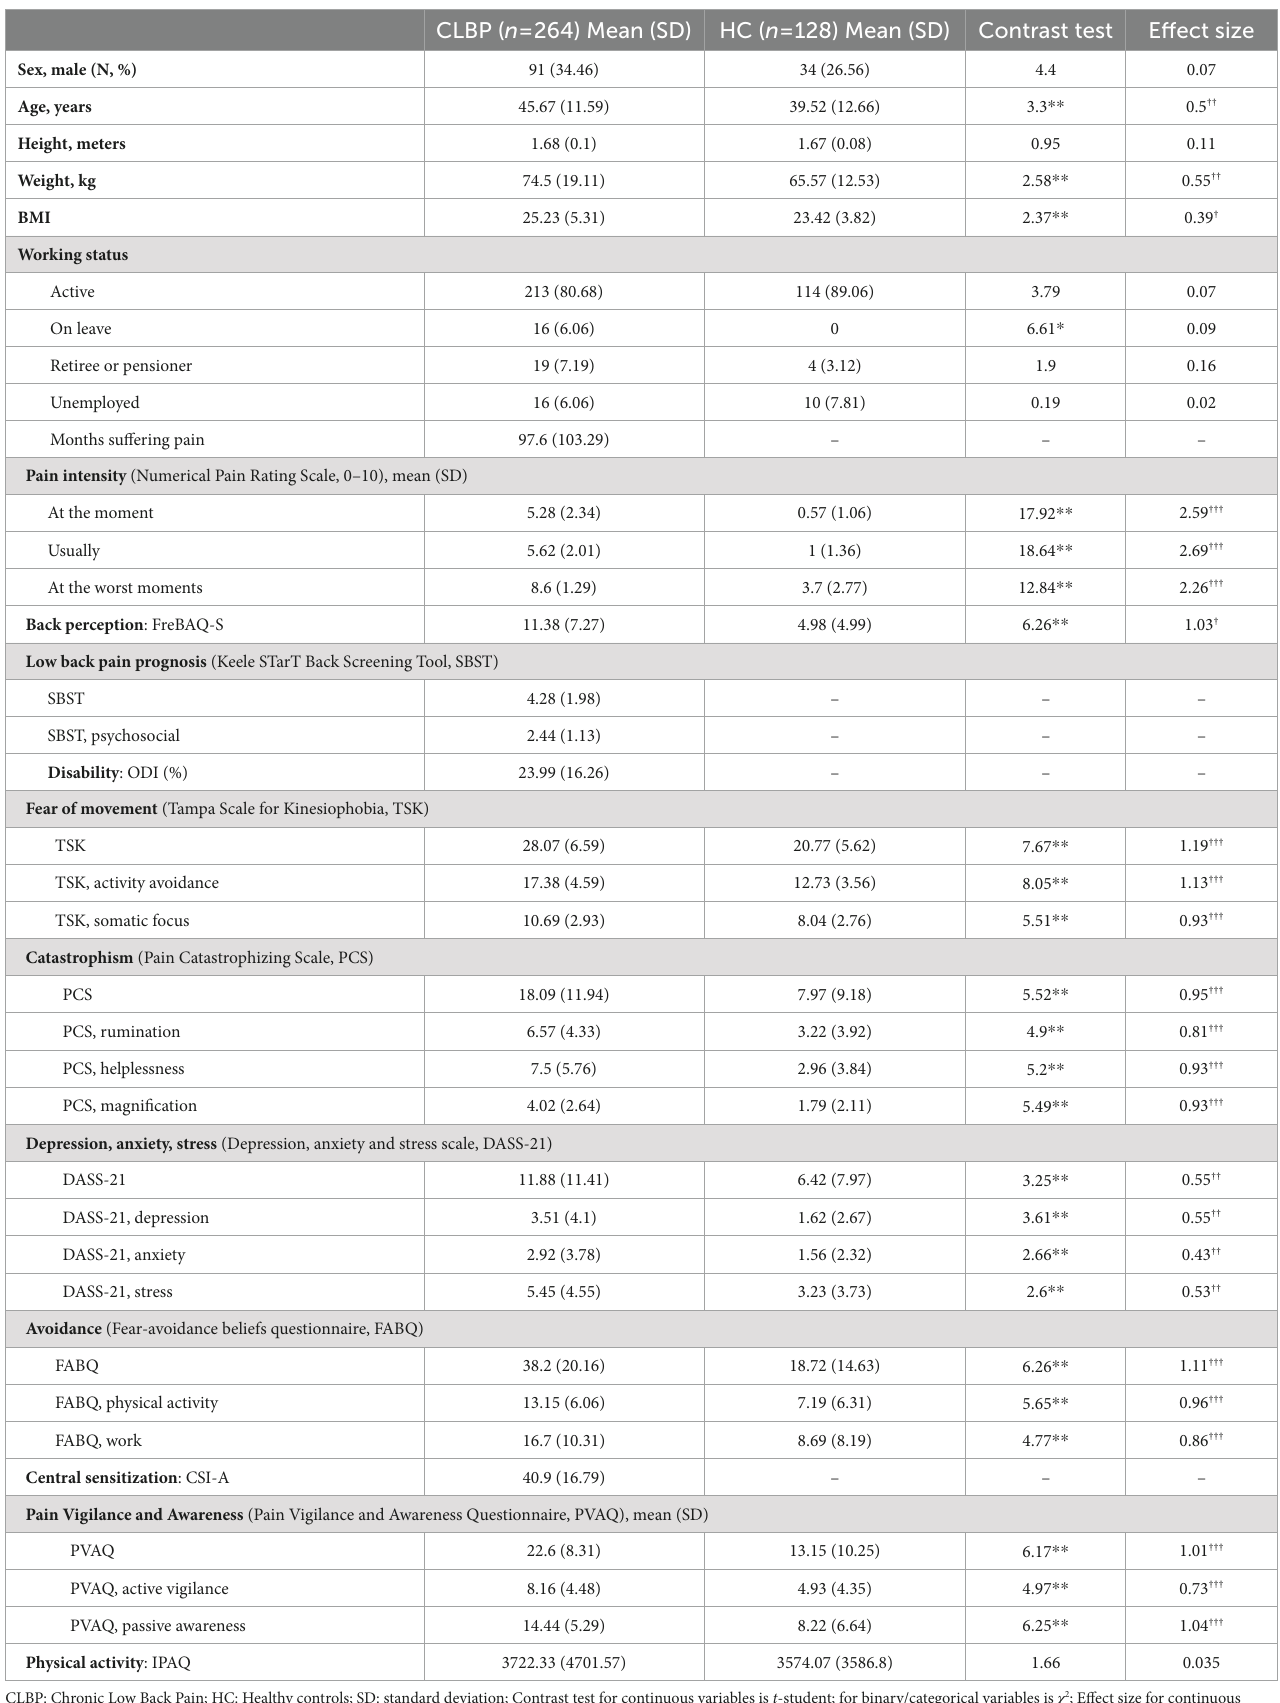
TABLE 1 Sociodemographic, clinical, and self-reported